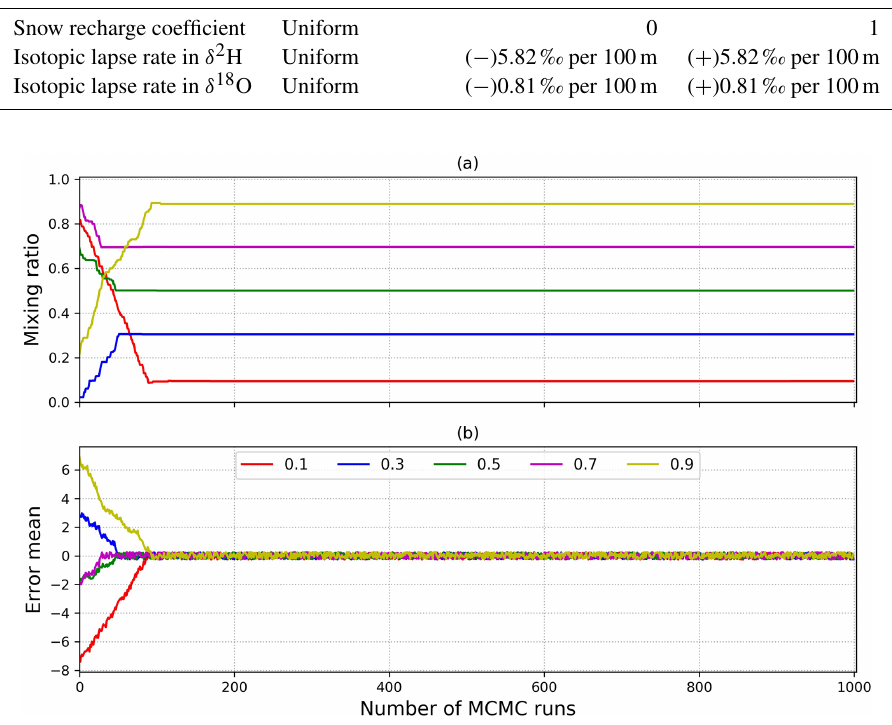
Figure 3. Diagnostic plots showing the convergence characteristics of MCMC chains for five different mixing ratios for the low variance dataset (shown in Table 3). Panels (a) and (b) show variations in the inferred mixing ratio and the error mean with increasing MCMC runs.